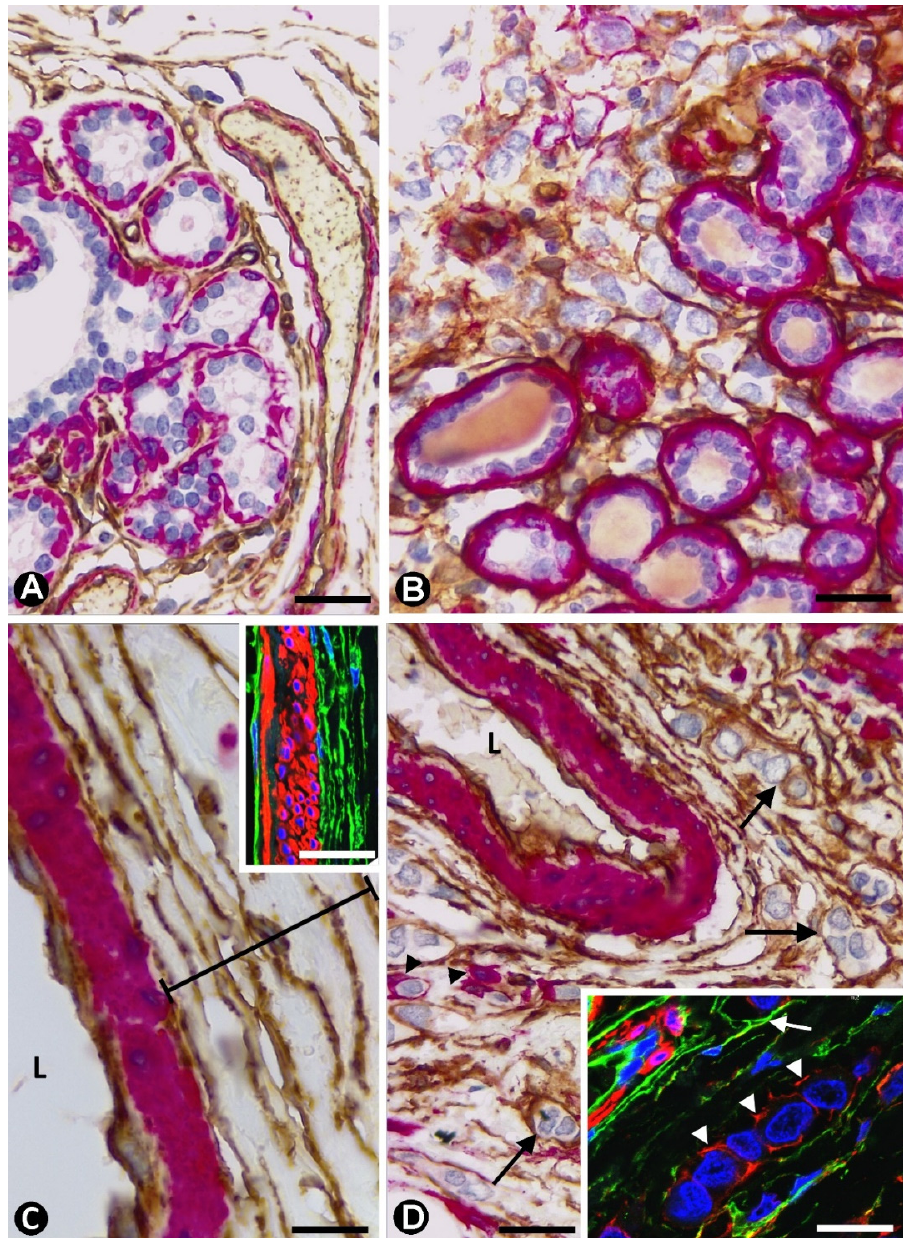
Figure 6. Double immunochemistry for CD34 (brown) and α SMA (red). Haematoxylin counterstain. ( A ): Part of a lobule in which CD34+SCs/TCs are observed in the interstitium. ( B ): CD34+ stromal cells surrounding neoplastic cells in the interstitium of a lobule. ( C ): Several layers of CD34+SCs/TCs are seen in the adventitia of an artery. The insert shows a similar image in double immunofluorescence labelling. ( D ): CD34+ stromal cells (arrows) and occasional α SMA+ cells (arrowhead) around neoplastic cells in the adventitia of an artery. The insert shows positivity for CD34 (arrow) and α SMA (arrowheads) in stromal cells. Bar: ( A , B , D ): 30 µm; C: 15 µm; Insert of ( C , D ): 60 µm.